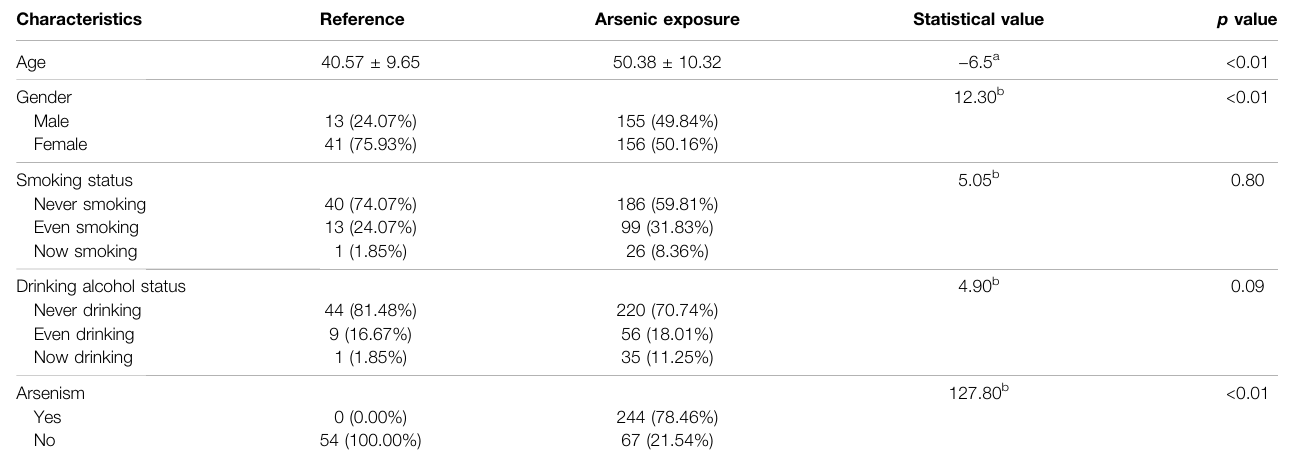
TABLE 1 | Characteristics of the study participants ( n =